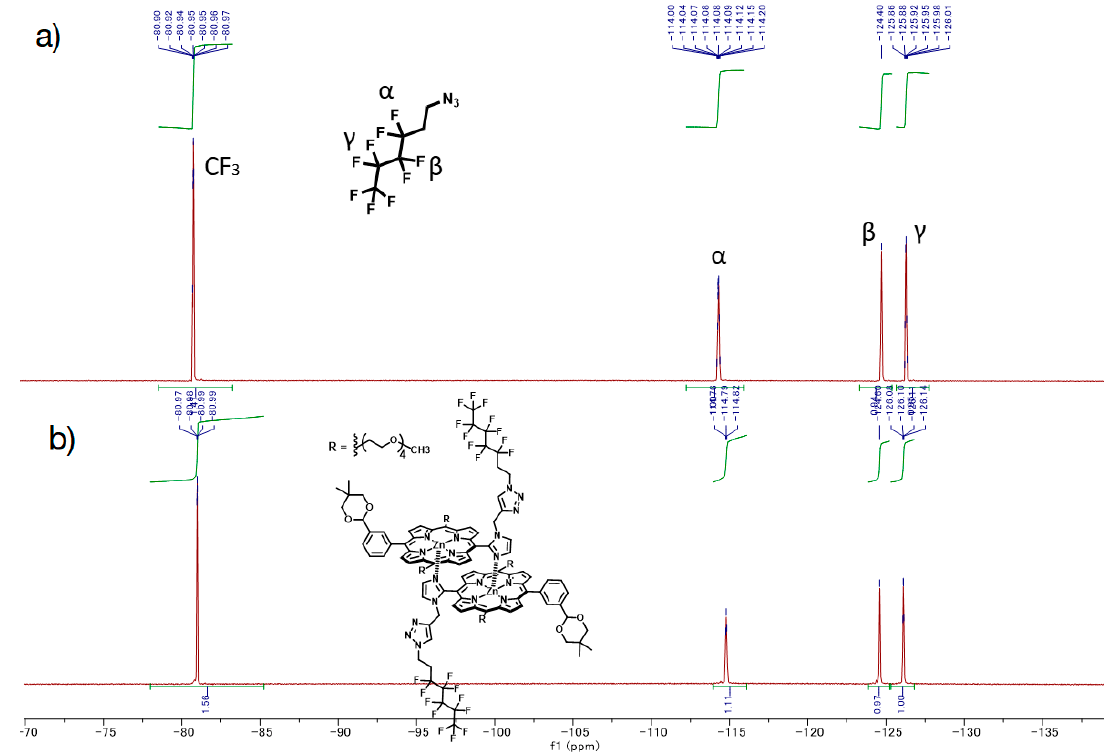
Figure 22. 19 F-NMR spectra (376.32 MHz, CDCl 3 , 298 K) of ( a ) F9-N3 and ( b ) dimer of F9-5Zn.